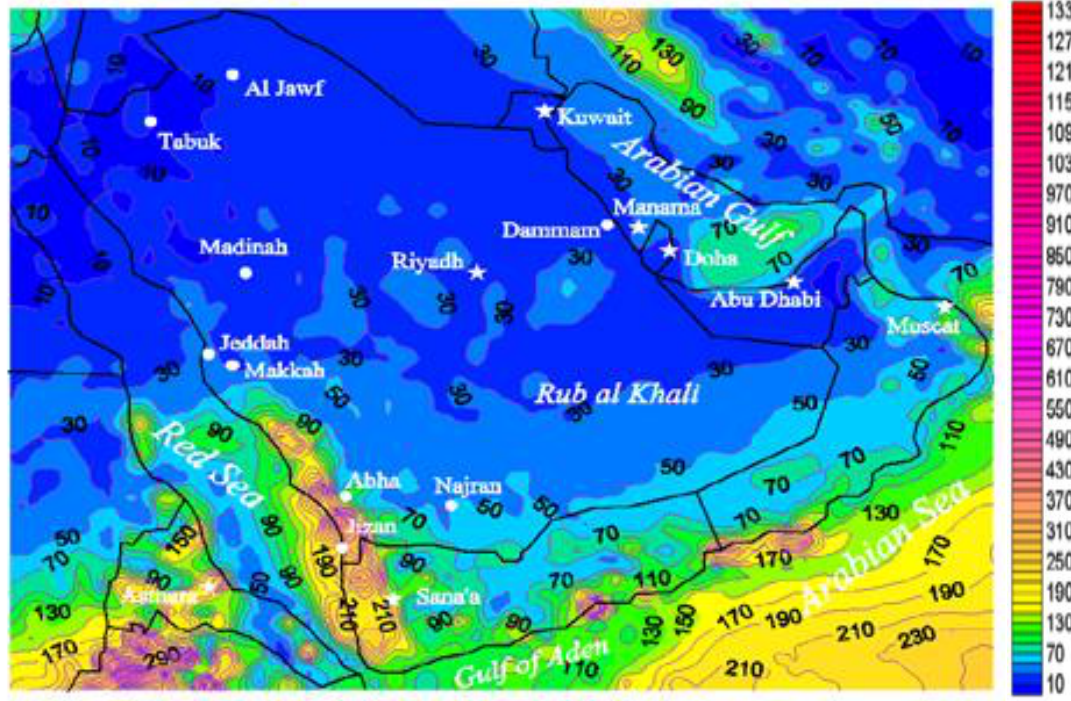
Figure 24. The spatial distribution pattern of the mean total autumn precipitation over the 2070–2100 period